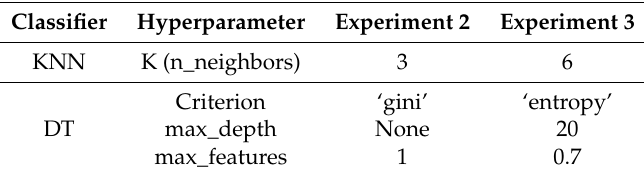
Table 4. The hyperparameters values for KNN and DT in Experiments 2 and 3. When max_depth is set to None, the decision tree is expanded until all leaves are pure